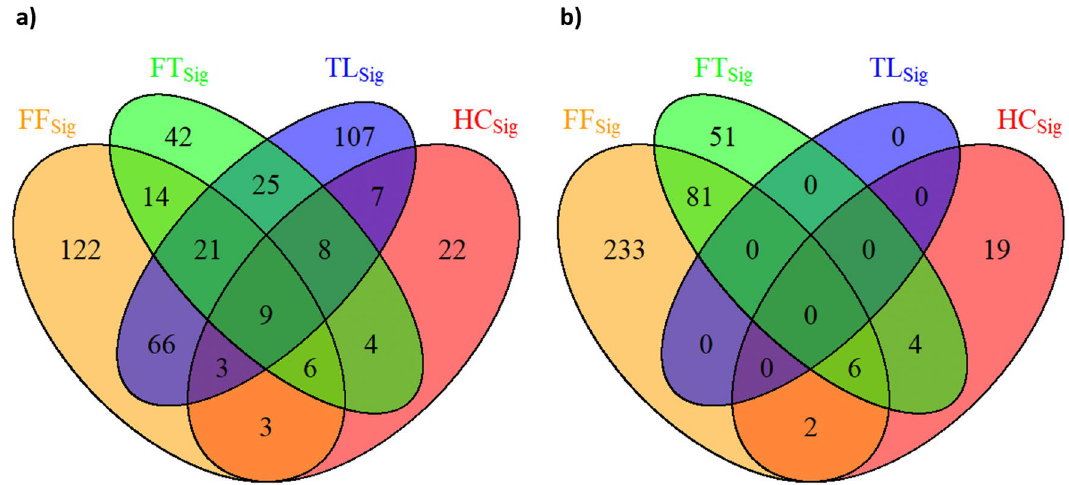
Figure 6. Venn diagram shows the distribution of GO terms that were associated with image feature signatures of FF Sig , TL Sig , FT Sig and HC Sig : ( a ) generated using the NRG-H dataset. ( b ) Generated using the NRG-S